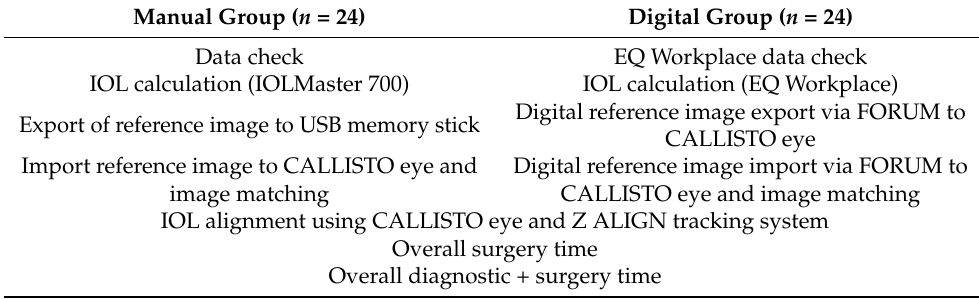
Table 1. Workflow steps and points of interest in the manual and digital